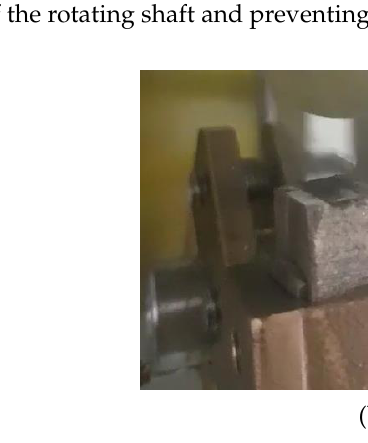
Figure 7. Test method for electric pitting prevention device.